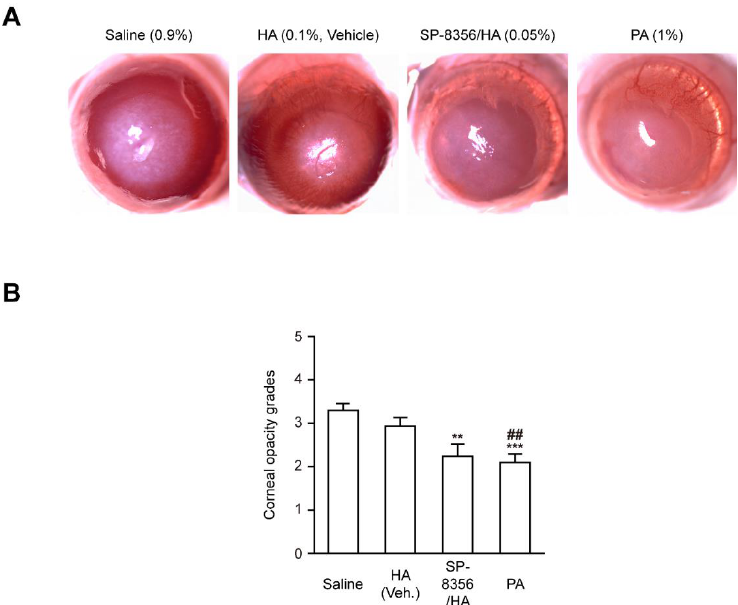
Figure 1. SP-8356 inhibits alkali-induced corneal haze at 2-week after alkali burn. ( A ) Representative images of corneal haze (HA; 0.1% hyaluronic acid, SP-8356 / HA; 0.933 mM SP-8356 dissolved in 0.1% hyaluronic acid, PA; 1% prednisolone acetate). ( B ) Quantitative analysis of corneal opacity ( n = 30 for saline, n = 34 for HA, n = 33 for SP-8356 / HA, n = 32 for PA). All values are shown as means ± standard deviation (SD, ** p < 0.01 vs. saline. *** p < 0.001 vs. saline. ## p < 0.01 vs.